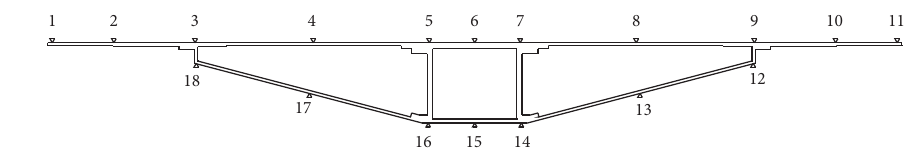
Figure 5: Arrangement of stiff girder stress measuring